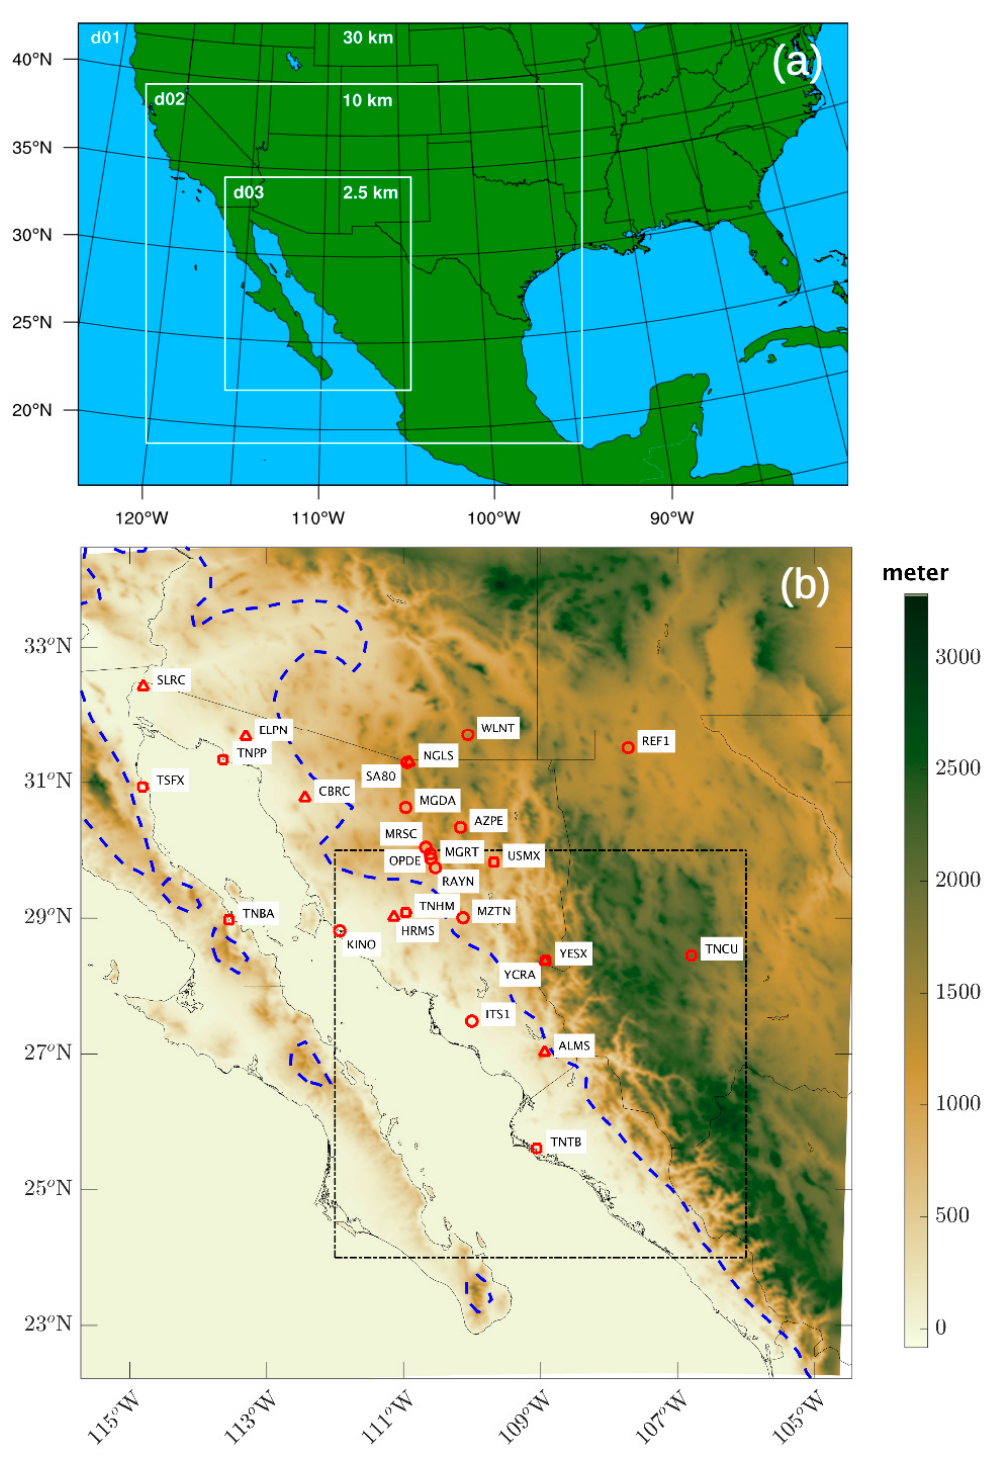
Figure 1. The Advanced Research version of the Weather Research Forecasting (WRF-ARW) nested domain configuration ( a ). The inner domain with plotted site locations ( b ). There are 12 temporary observation sites (circles), 8 observation sites of Trans-boundary, Land and Atmosphere Long-term Observational and Collaborative Network (TLALOCNet) (squares), and 7 observation sites of Comisión Nacional del Agua (CONAGUA) (triangles). Terrain elevation is shaded from 0 m to about 3000 m above mean sea level. The monsoon core region (24°–30° N and 112°–106° W) set up by NAME 2004 is outlined in black dash lines. Elevation cutoff at 500 m is outlined in a blue dashed line, separating the mountainous sites (>500 m) from the coastal sites (<=500 m).